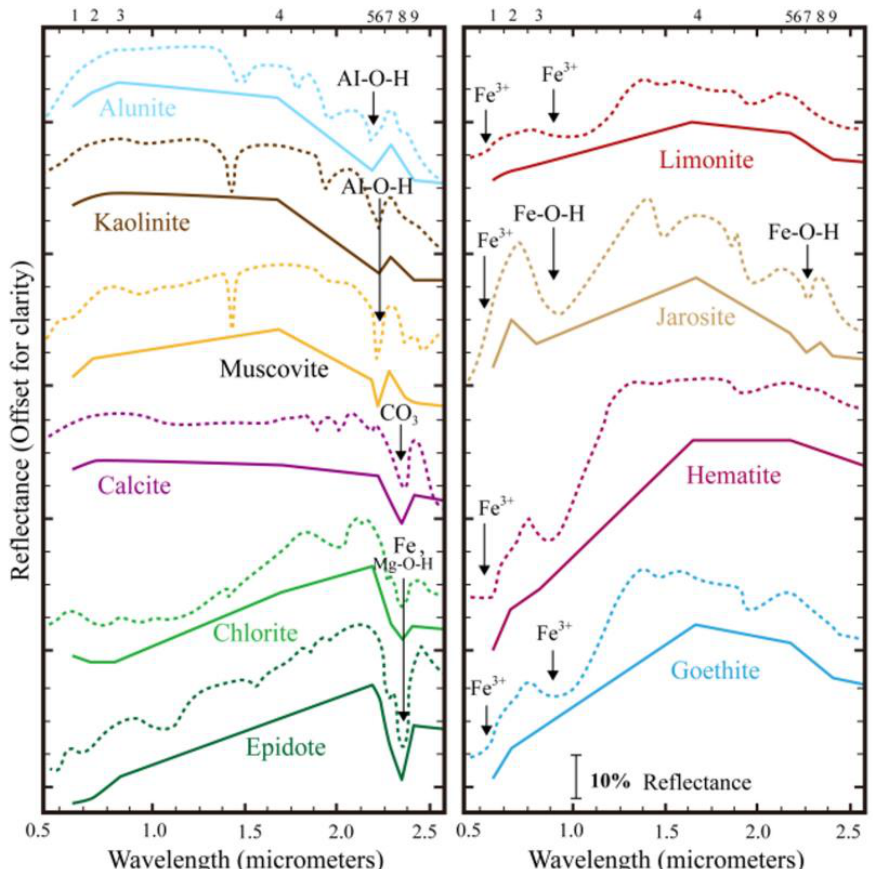
Figure 2. Laboratory spectra of alteration minerals in the study area [34]. The lines in the figure indicate the spectral change curve of the mineral or element and the corresponding ASTER image band, with the arrow pointing to highlight the apparent change of that mineral or element.